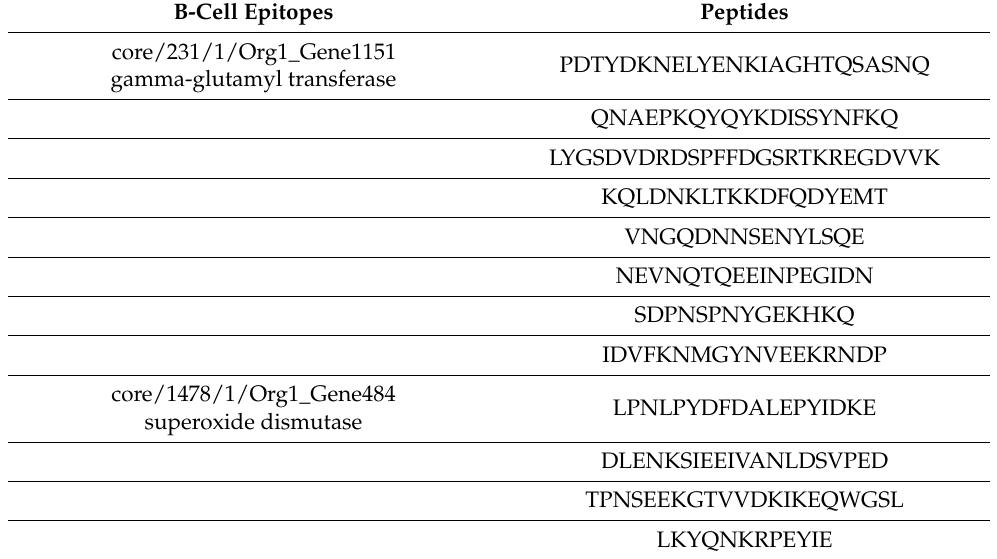
Table 3. B-cell epitopes for selected proteins. B-Cell Epitopes